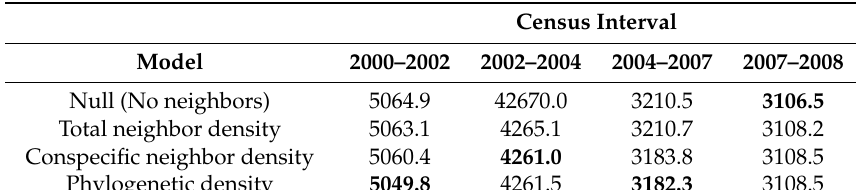
Table 1. AIC values for model comparisons. Bold values indicate the best fit model (i.e., lowest AIC) for each census interval.